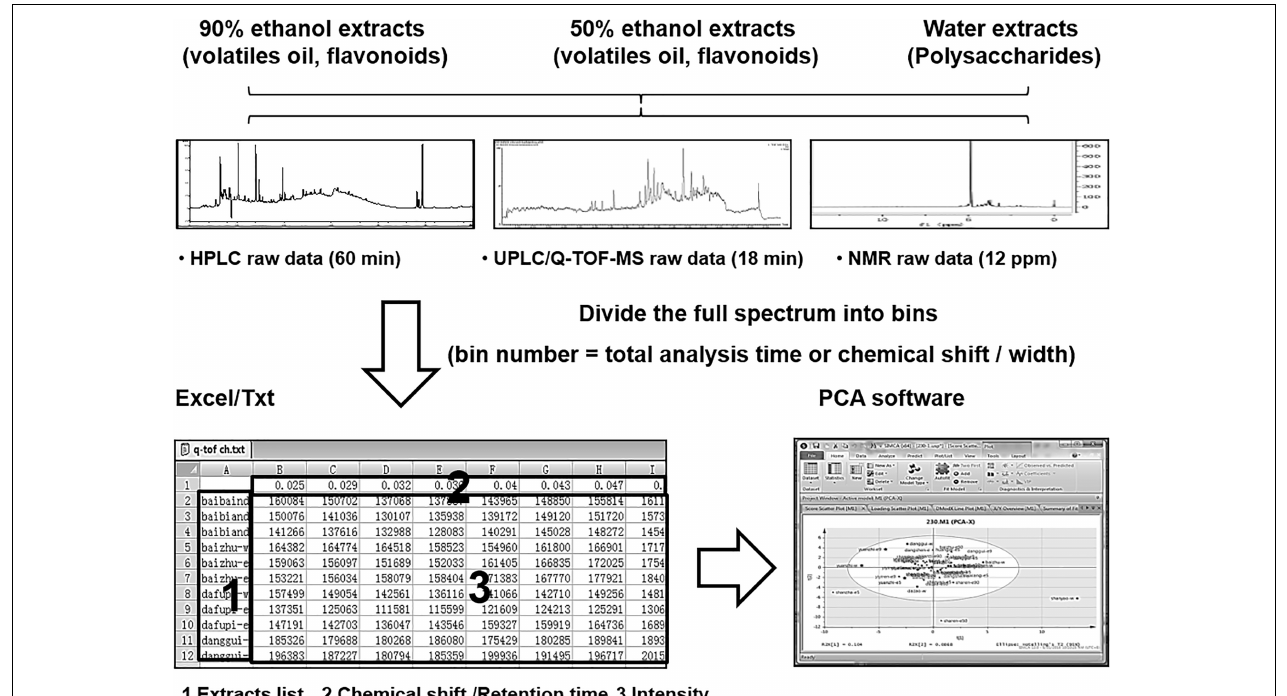
FIGURE 5 | The procedure of full spectrum principle component analysis. The spectrums were firstly divided into bins according to the resolution of analytic methods with its corresponding softwares (Agilent MassHunter workstation software version B.01.00 for HPLC, Waters MassLynx V4.1 SCN923 for LC-MS and MestReNova 6.1.1 for NMR). The intensity of each bin was extracted and arranged as the figure showed. The obtained excel or txt file was further subjected into PCA software (SIMCA-P+ version 12.0, Umetrics,